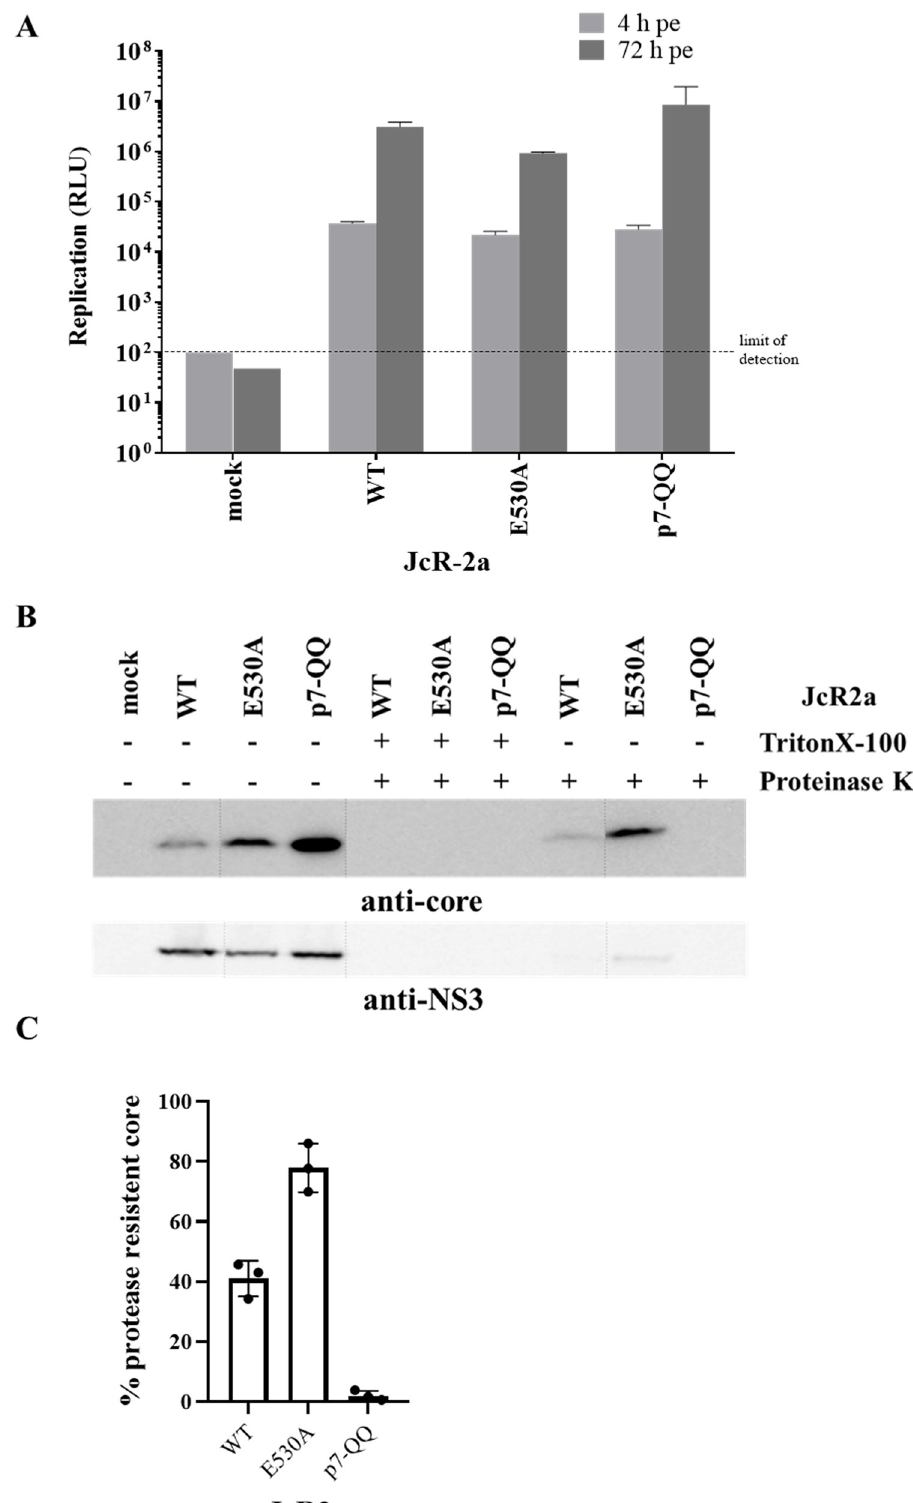
Fig 7. NS3 mutation E530A do not interfere with HCV nucleocapsid envelopment. (A) Huh7.5 cells were electroporated with indicated HCV RNAs and viral RNA replication was analyzed at 4 h and 72 h pe. The